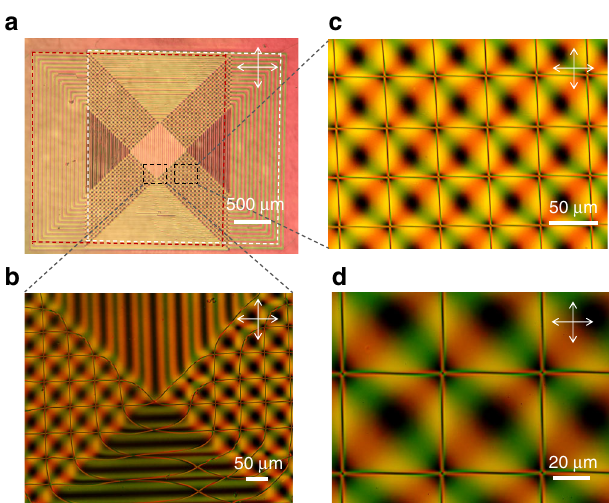
Fig. 4 Two-dimensional web of 1/2-strength twist disclinations induced by the surface orientational pattern. a Entire top view of the LC layer between partly overlapped square patterns shown in Fig. 1a (surrounded by broken red and white lines ) observed between crossed polarizers. b Magni fi ed view of a at the lower corner of the central region. c , d , Magni fi ed polarized micrographs of a showing the square web of disclinations. The color contrast manifests the local twist and birefringence. The lattice spacing of the disclination web is 53 μ m, commensurate with the periodicity of surface alignment. Disclination lines that were initially present in the central region were quickly annihilated, leaving a single loop of diagonal line surrounding the area. In the lower segment, the stripe patterns from the bottom and top substrates are horizontally parallel where the disclination lines are of the same handedness, assuring their stability. All the web structure is inde fi nitely stable, once the central region becomes disclination-free. Around the intersection c , d , the twist angle is 0, π , 0, and − π counter clockwise from the fi rst quadrant. On the diagonal connecting the left bottom intersection and the right top one, the twist angle is 0, but the optic axis is continuously winding in-plane as manifested by the periodic change of contrast. With the birefringence of ZLI-2293 being Δ n ~ 0.13, the interference color gives the estimate of the cell thickness to be ca. 10 μ ultra violet light. The alignment pattern was fi rst split into seg- ments of identical orientation, and each segment was sequentially irradiated onto a glass substrate coated with a photoaligning azo dyes 20 while adjusting the polarization direction as desired. At